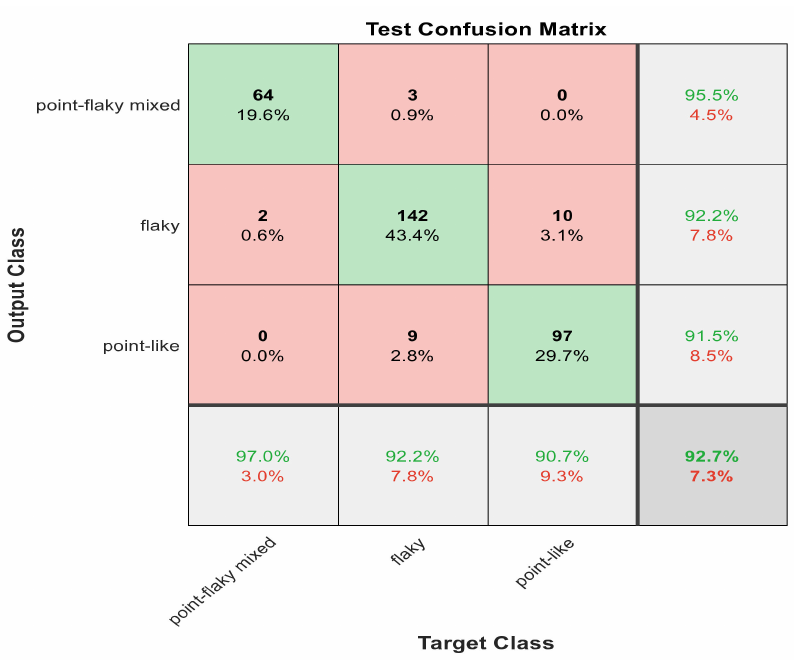
Figure 10. The confusion matrix with ECFS-reduced features for the whole cascading system.